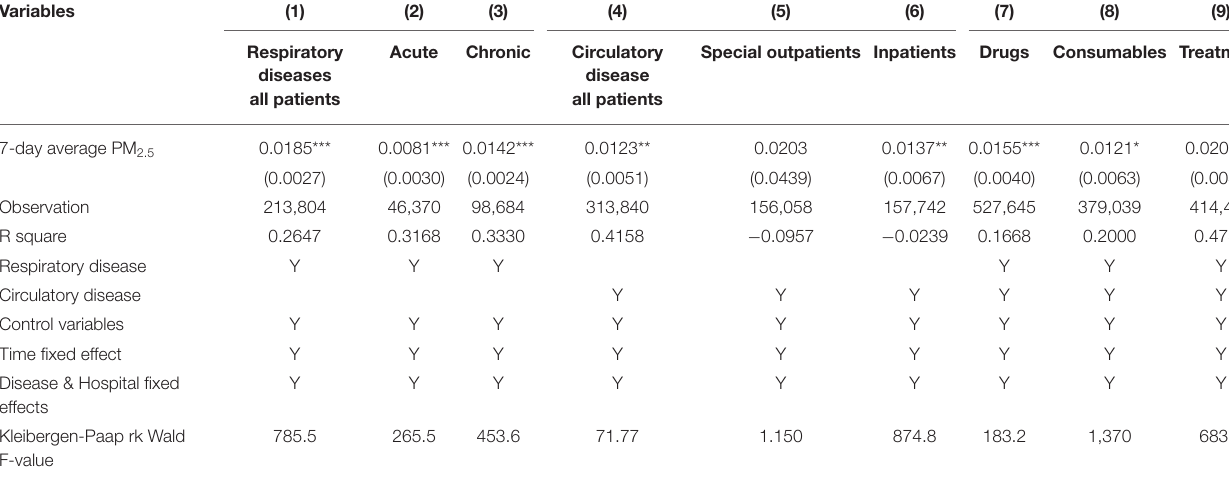
TABLE 6 | Impact of PM 2.5 on cost of visit: heterogeneity